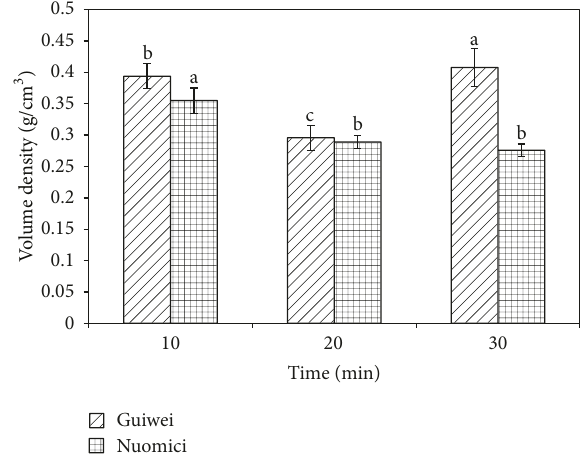
Figure 6: Effect of ultrasound on volume density of FD Feizixiao lychee. ((a), (b), (c)) Values in the same column not sharing the same superscript are significantly different ( 𝑝 < 0.05 ).